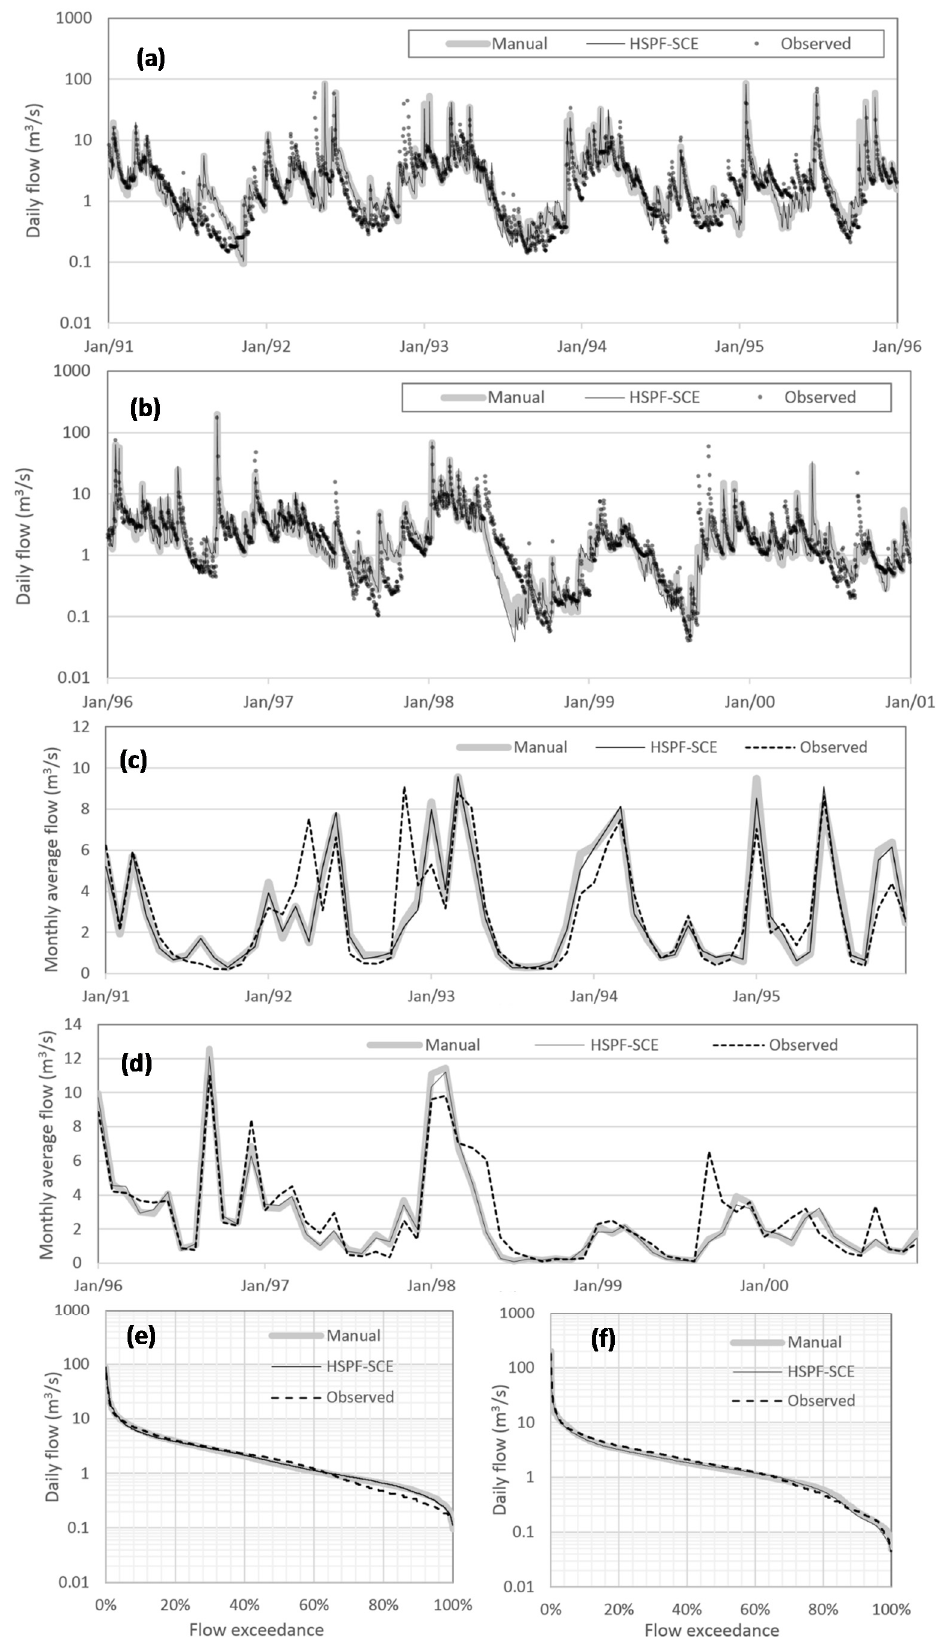
Figure 7. Comparison of the observed and simulated daily and monthly hydrographs with the selected parameter set for the Piney River watershed. ( a , b ) daily hydrographs; ( c , d ) monthly hydrographs; and ( e , f ) flow duration curves of daily